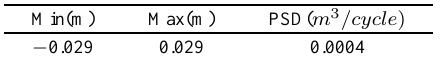
Table 1 Stochastic characteristic of road random